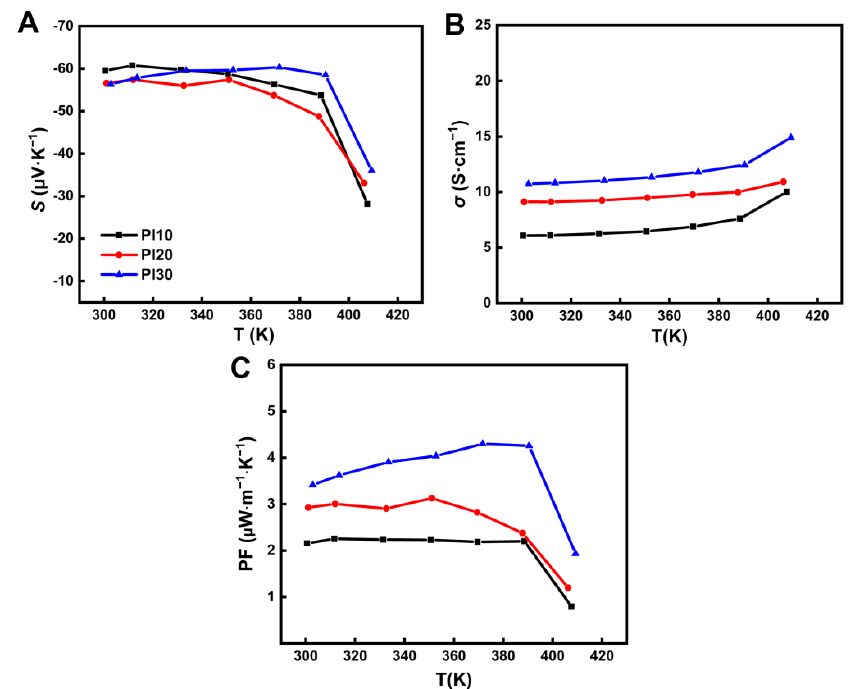
Figure 3. Temperature dependence for ( A ) Seebeck coefficient, ( B ) electrical conductivity, ( C ) power factor of the PI10, PI20, and PI30.